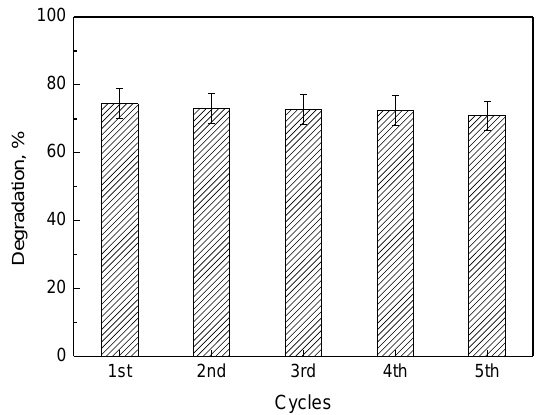
Figure 7. Degradation (%) of Orange G aqueous solution using the same 3C 60 /MCM-41 powder (1–5 cycles). The initial concentrations of methyl orange and ascorbic acid were 25 μM and 0.50 mM, respectively.